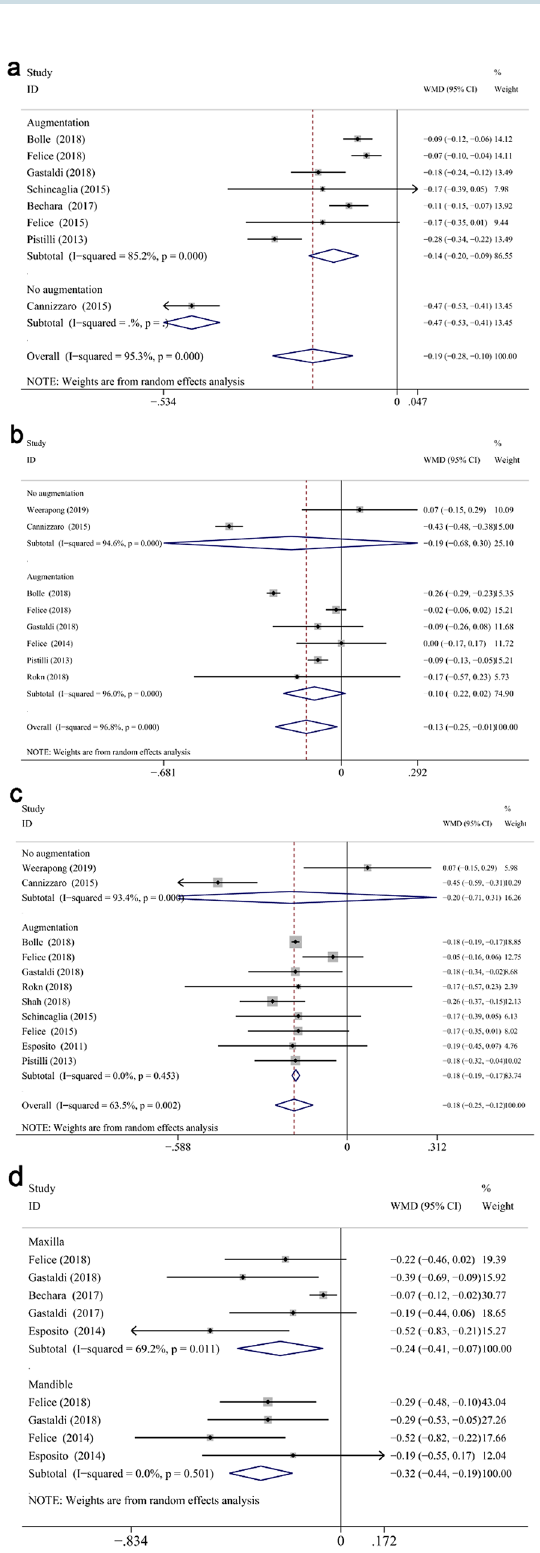
Figure 8. Subgroup analyses for the effects of augmentation on marginal bone loss, with baseline at implant placement, in maxilla ( a ), mandible ( b ) and both jaws ( c ) at 1-year. Subgroup analyses of maxilla/mandible on MBL (from IP) at 3-years follow-up ( d ). Negative value in difference in means indicates more MBL in the longer implant